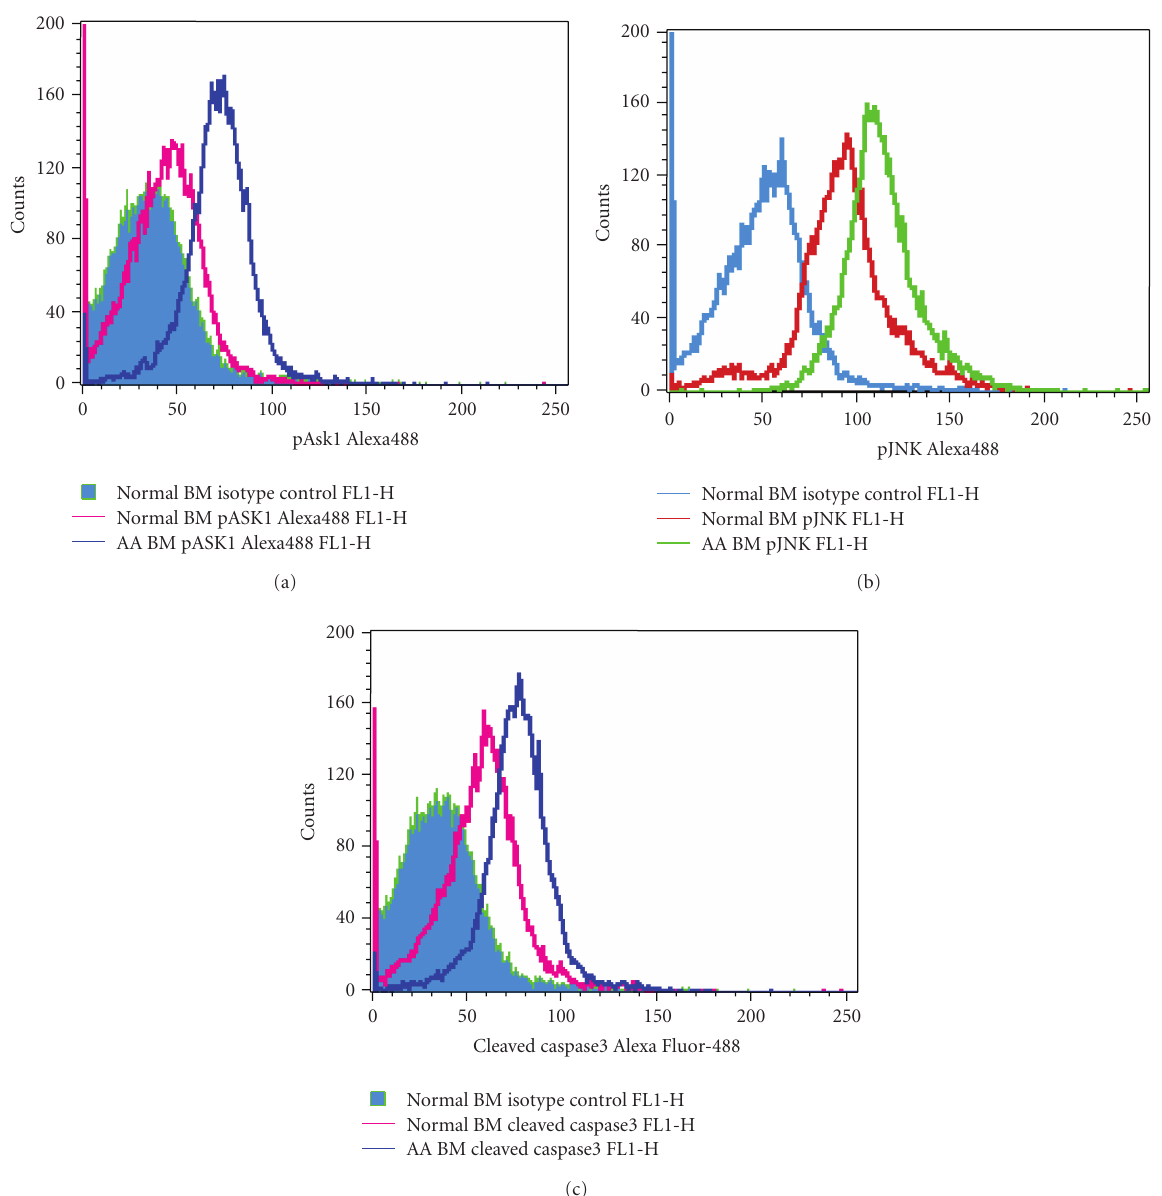
Figure 7: Flowcytometric analysis of intracellular apoptosis inducer proteins levels in normal and aplastic bone marrow cells. (a) Aplastic bone marrow cells (blue line) labeled with p-ASK1 showed a significant increase in median value of fluorescence intensity compared to the normal (red line). (b) Aplastic bone marrow cells (green line) labeled with phospho-JNK documented a significant increase in median value of fluorescence intensity in comparison with the normal (red line). (c) Aplastic bone marrow cells (blue line) labeled with cleaved caspase-3 documented convincing increase in median value of fluorescence intensity as compared to the normal (red